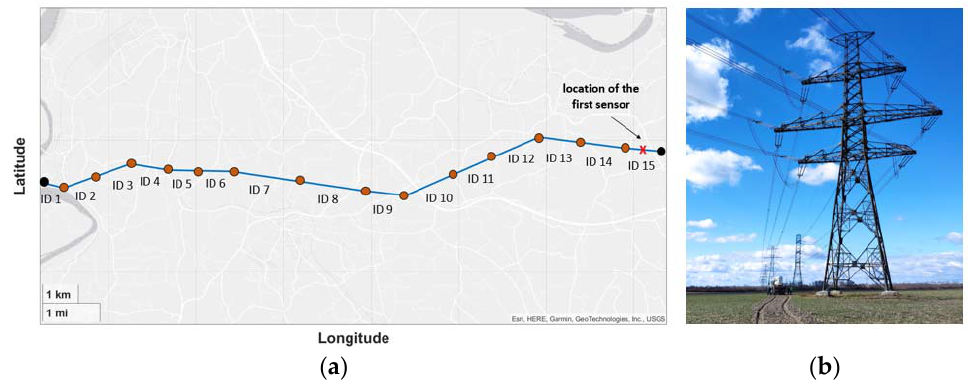
Figure 5. The case study of a 220 kV power line: ( a ) tension sections of the line with IDs; ( b ) image of the tension section with ID 15.